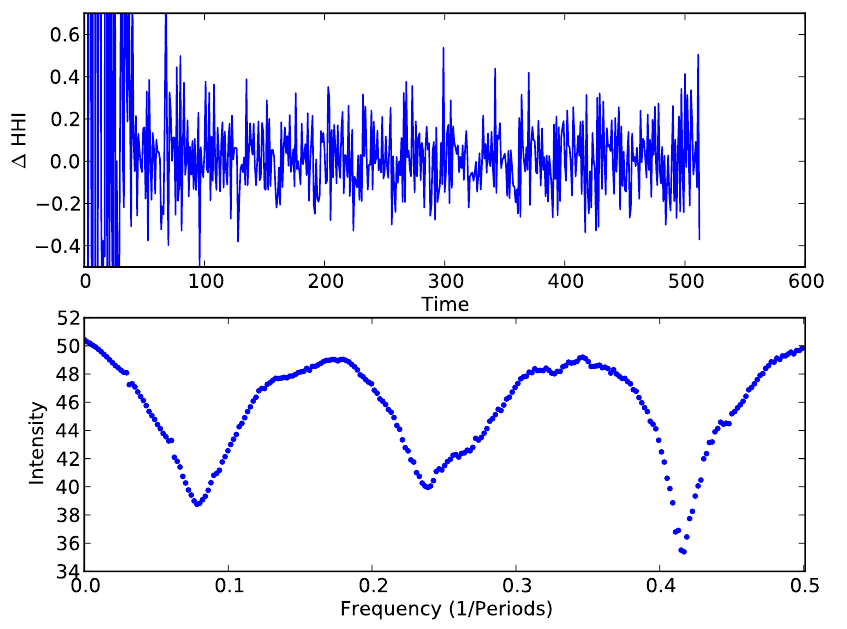
Figure 15. Development of the growth (rates) of the Herfindahl-Hirschman Index and the frequency spectrum of that time series for ↵ = 3 . 0